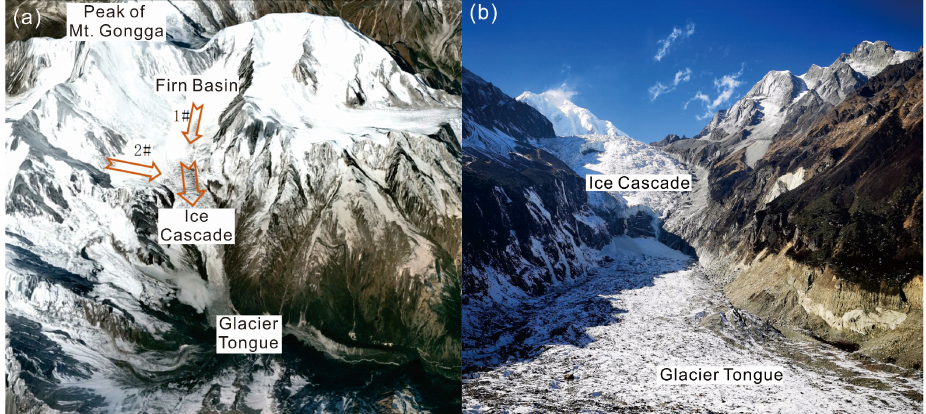
Figure 4. Satellite image and photo of the Hailuogou Glacier. ( a ) Three-dimensional image of Hailuogou Glacier (shot on 23 December 2017), where the arrows with tag 1# and 2# represent the two main directions of surface movement in the firn basin, and the other arrow stand for the movement direction on ice cascade; ( b ) photo of Hailuogou Glacier (shot on 3 February 2021).